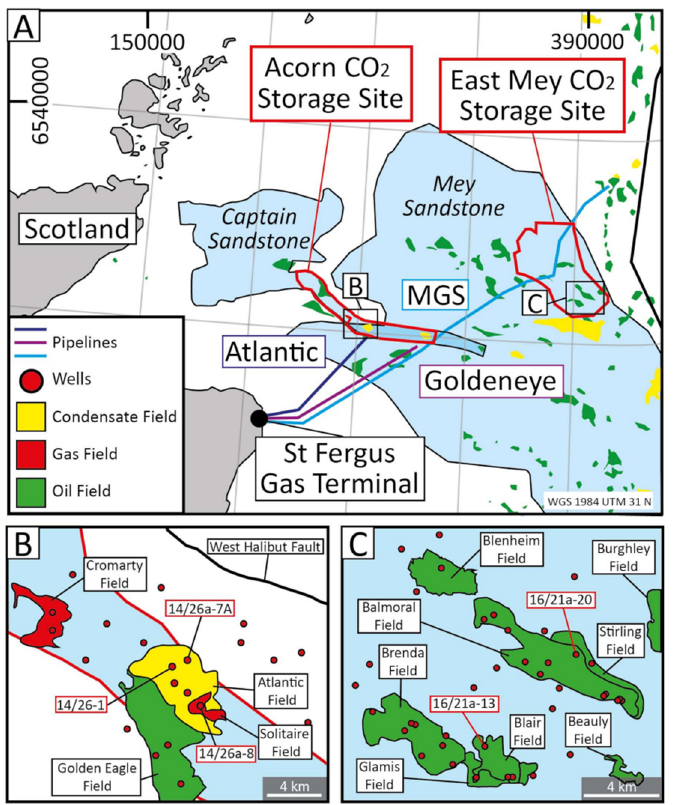
Figure 1. ( A ) Location of Acorn and East Mey CO 2 Storage Sites in the study area in the western North Sea. The extents of the Captain Sandstone Member and the Mey Sandstone are shown in blue. The extents of the Acorn CO 2 and the East Mey Storage Sites are highlighted in red. Petroleum fields and pipelines extending from the St Fergus Gas Terminal to the study areas are included. The pipelines may be repurposed to deliver CO 2 offshore for subsurface storage. ( B ) Map of the Acorn site for the Atlantic and related fields with well locations indicated. ( C ) Map of the East Mey site for the Balmoral and related fields with well locations indicated. All figures modified after Williams, Fellgett and Quinn [7], Pale-Blue-Dot-Energy [9], Pale-Blue-Dot-Energy